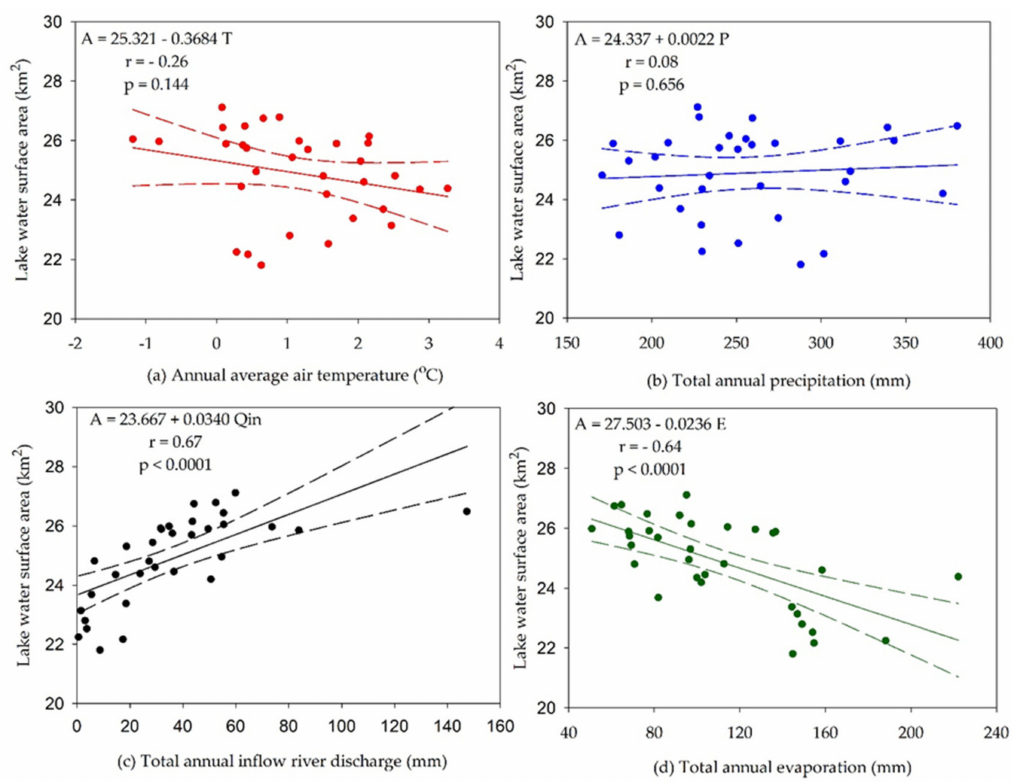
Figure 12. Linear regression for a relationship between the water surface area of the lake and variables such as ( a ) air temperature, ( b ) precipitation, ( c ) river flow, and ( d )